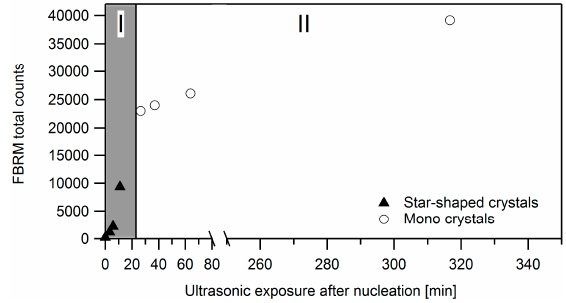
Figure 11 . Measured total FBRM counts at the moment that sonication is disabled as a function of the ultrasonic exposure time after the detection of nucleation. The final morphology after completion of the crystallization protocol is indicated and exhibits two distinct areas. Insufficient exposure in zone I results in star-shaped crystals, while mono-crystals are obtained in zone II.